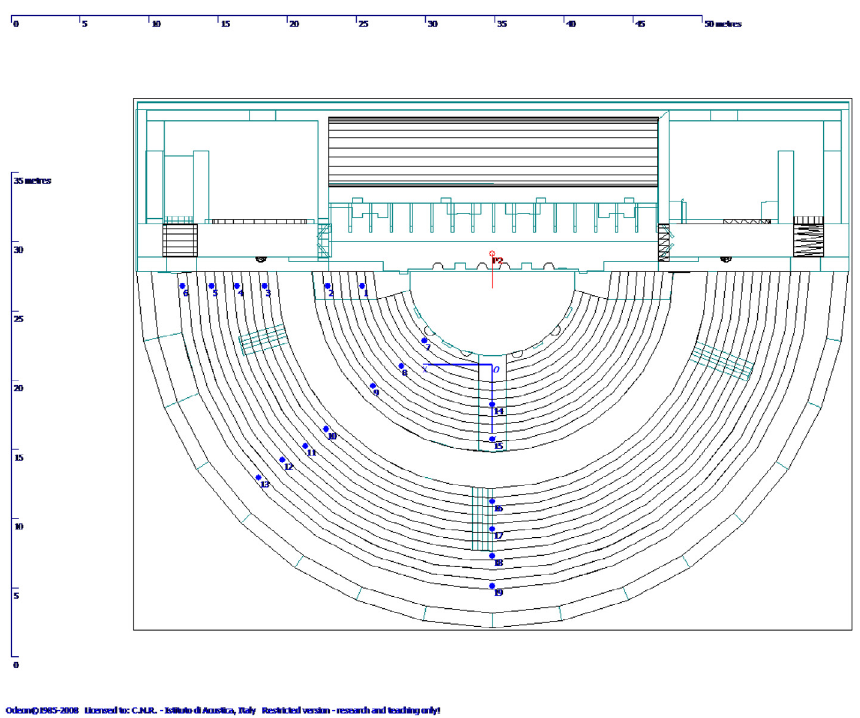
Figure 2. Top view of the 3D model of the theatre of the Pythion at Gortyna with source (red point) and receivers (blue points).